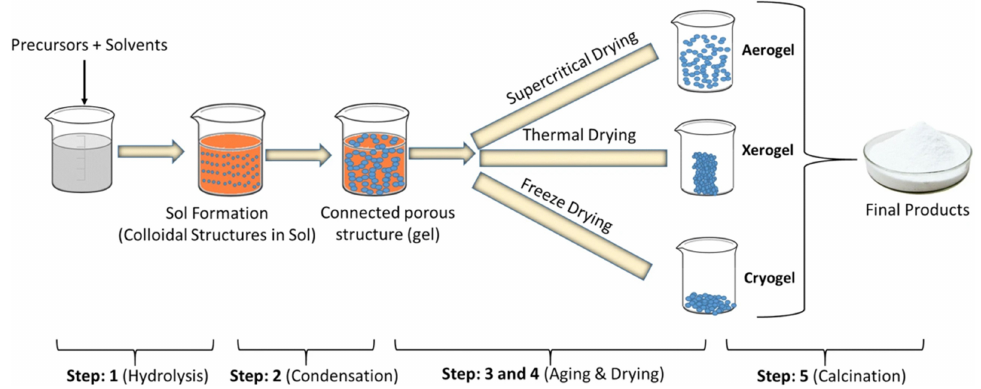
Figure 6. Schematic procedure of synthesizing nanomaterials via the sol–gel technique. Reproduced with permission from